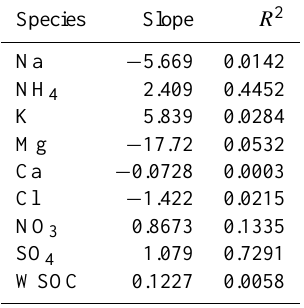
Table 4. Correlation coefficients and slopes between κ values and mass fractions of individual ions and WSOC.